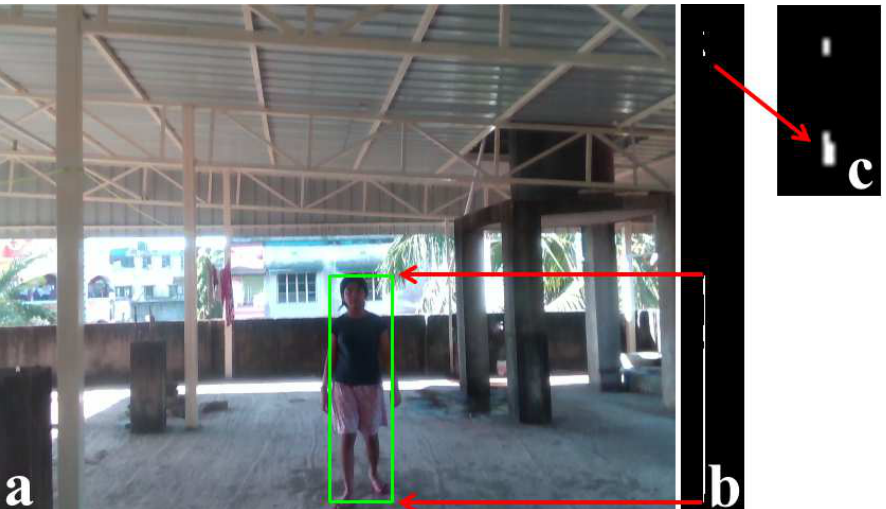
Figure 8. Estimation of the height of an obstacle using the proposed restricted v-depth map. ( a ) Same image used in Figure 6 and the result of the proposed technique. ( b ) Result of the thresholded restricted v-depth map. ( c ) The magnified view of the thresholded restricted v-depth map shows the portion of the roof as a separate